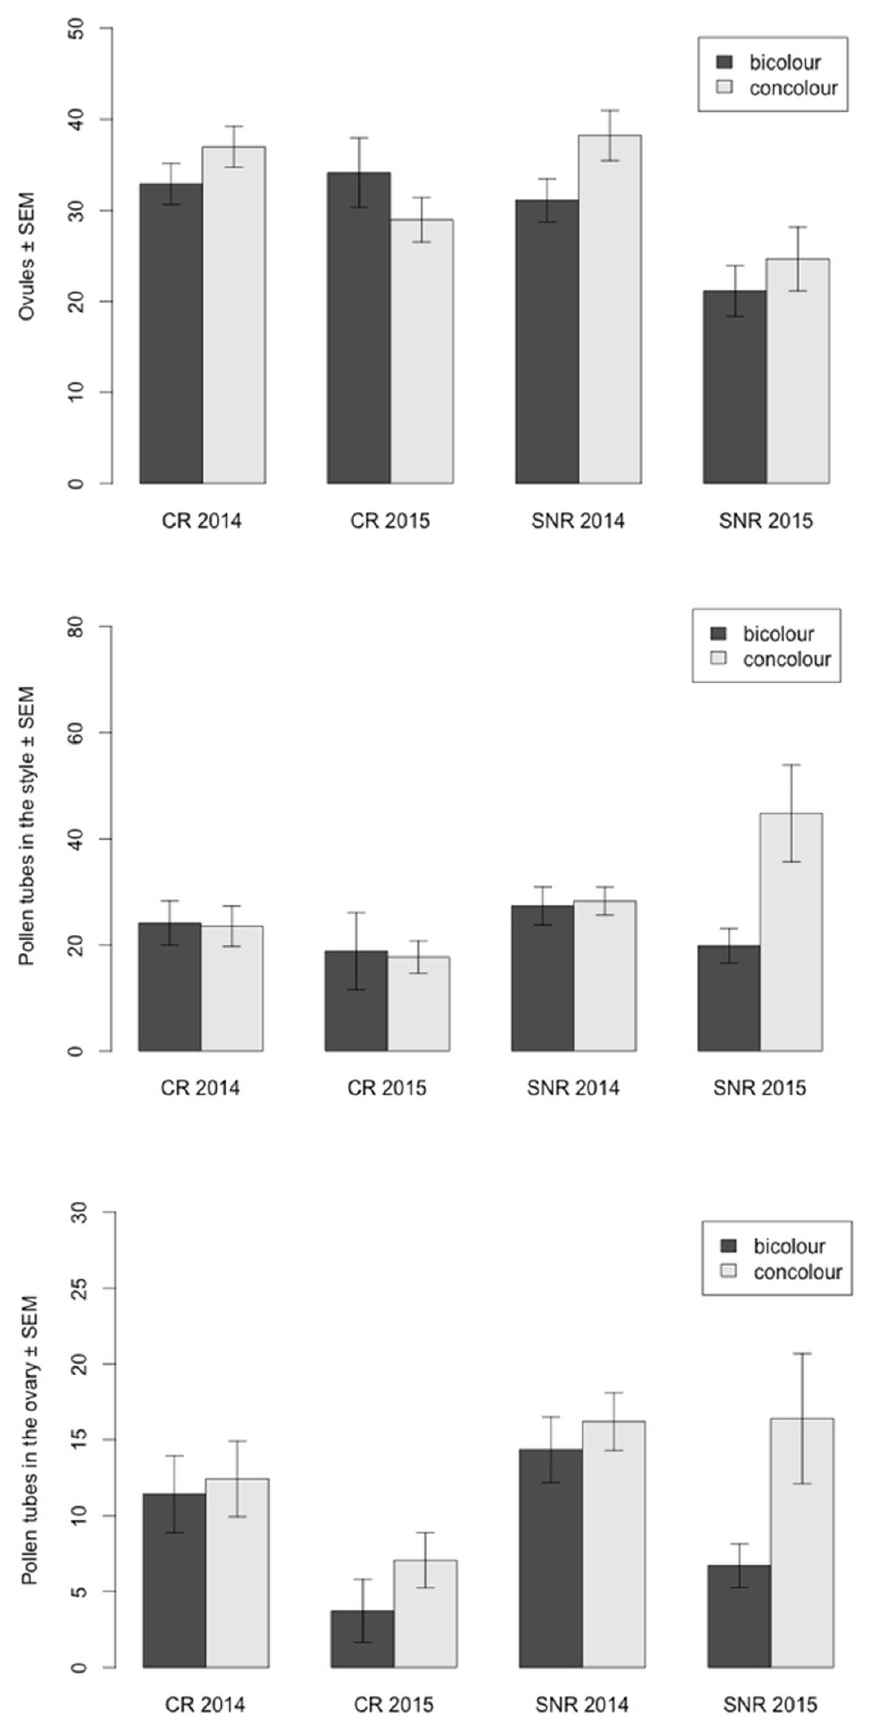
F IGURE 8. Mean number of ovules per flower in two morphs of Viola pedata at two sites and two years in Missouri, USA.